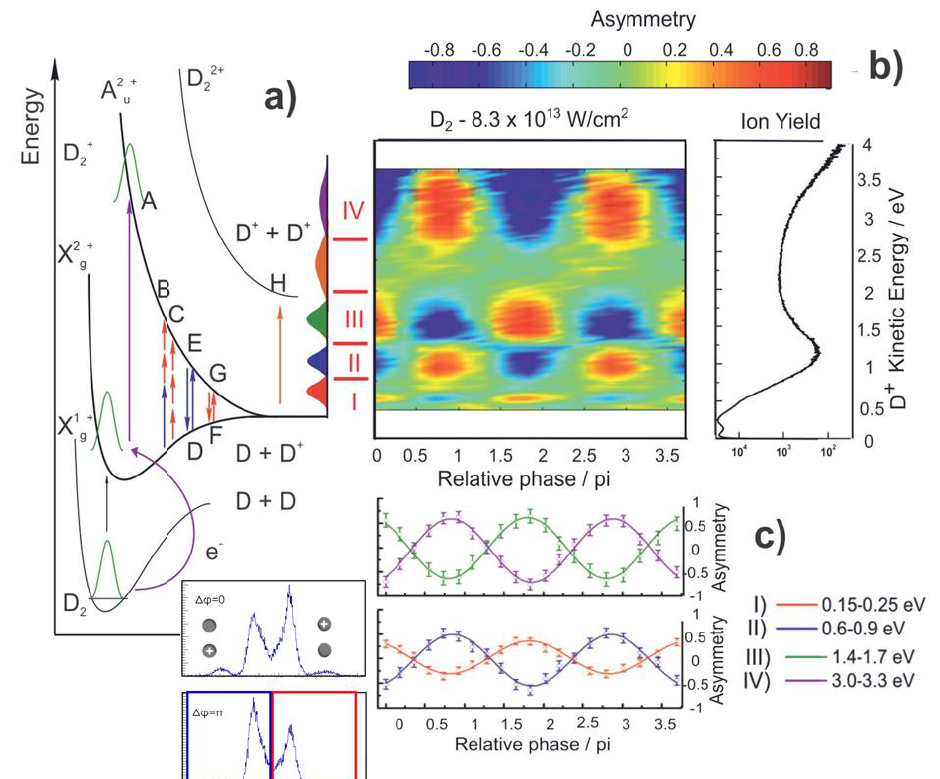
Fig. 1. Principle of D 2+ dissociation control experiment with control channels at different kinetic energy (KE) regions, as indicated with roman numbers. (a) Scheme of the reflection principle associated to the formation of D + ions from bond softening (red KE region), above-threshold dissociation (blue KE region), three-photon dissociation (green KE region), charge-resonance- enhanced ionization (orange KE region, no control) and recollision excitation (purple KE region). Capital letters correspond to different pathways. Blue arrows indicate absorption of 2  photons, red arrows of  photons. The two insets show the occurring asymmetry depending on the relative phase  in the time-of-flight spectrum. The left two peaks correspond to D + fragments pointing towards the detector, the right two peaks correspond to D + fragments pointing away from it (b) left panel: experimental calculated asymmetries for the detected D + fragments at an intensity of 8.3 × 10 13 Wcm −2 and right panel: corresponding logarithmic energy distribution. (c) Averaged asymmetries for the specified KE cut